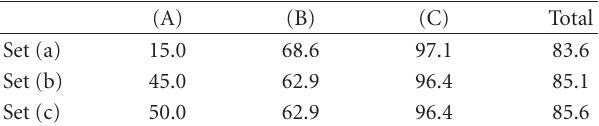
Table 7: Discrimination